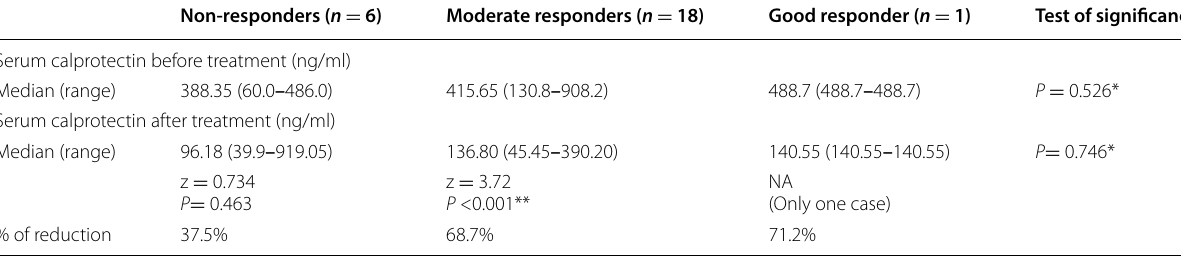
Abbreviations : NA not applicable, n number ** P 0.05; statistically significant ≤ * Calculated using Kruskal – Wallis